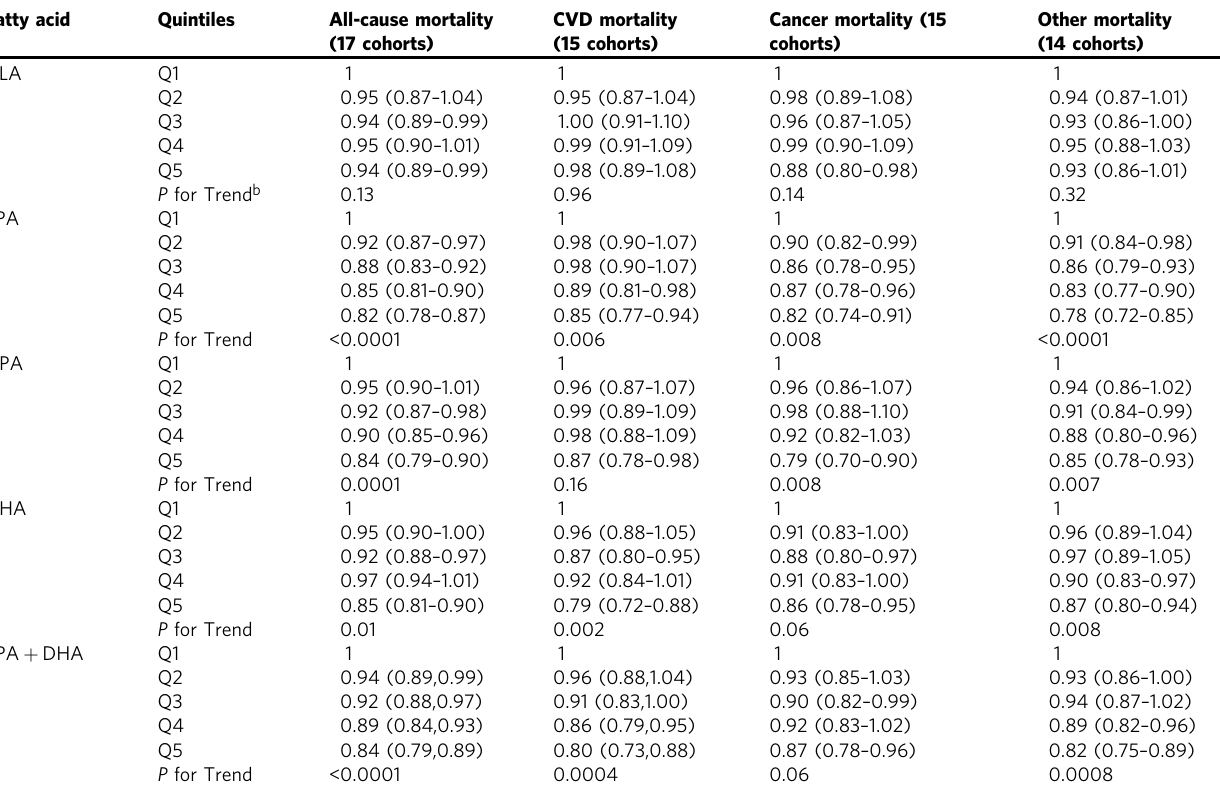
Table 3 Meta-analysis of circulating n-3 PUFA biomarkers with mortality types by cohort-speci fi c quintiles (hazard ratios and 95% CIs a ): Fatty Acids and Outcomes Research